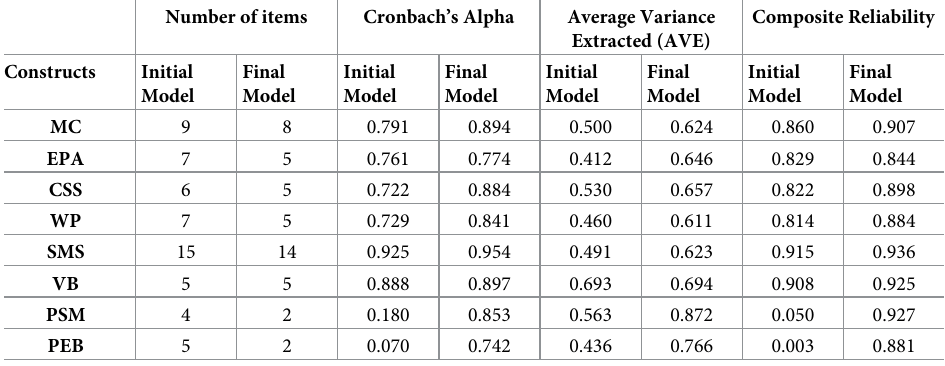
Table 4. Reliability and convergent validity: Comparison of the initial and final structural